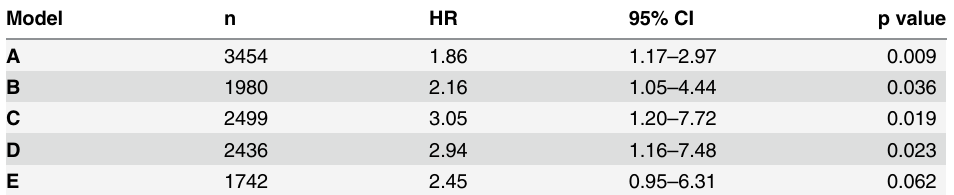
Table 2. Hazard ratio for NLR (cid:1) 1.2 compared to NLR < 1.2 in predicting cardiovascular event inci- dence in five